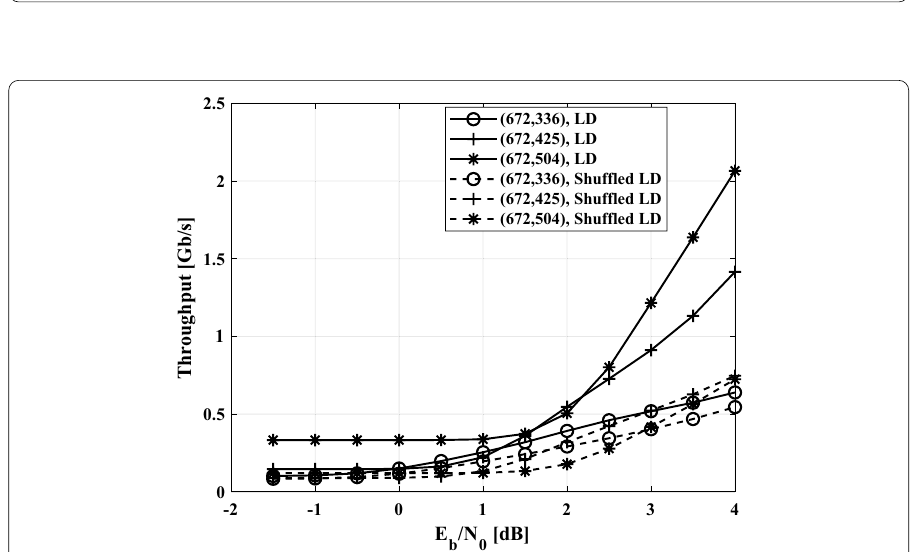
Fig. 11 Average throughput for the example QC-LDPC codes